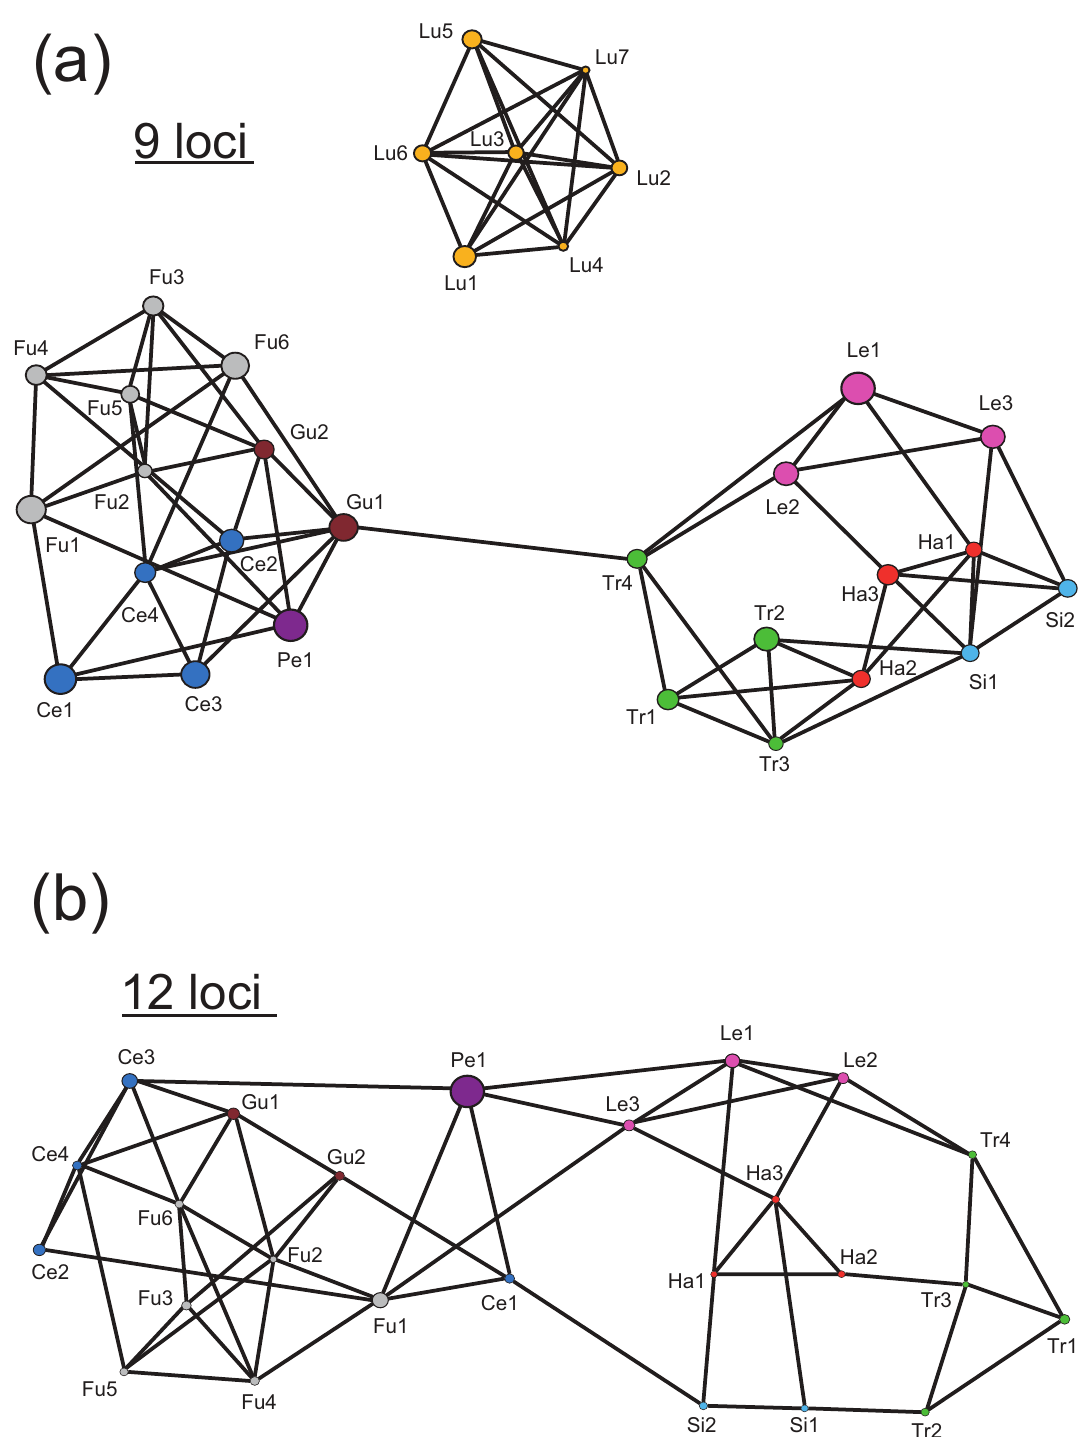
Fig 5. The results of analysesusing the POPULATION GRAPH program. (a) all populationsbasedon the nine core loci: (b) eight species (i.e. excludingdata for A . lutchuense ) based on 12 loci. Individualspecies are denotedby circles of different colors: yellow for A . lutchuense (Lu), blue for A . celsum (Ce), gray for A . fudsinoi (Fu), brown for A . gusk (Gu), dark purplefor A pellucidum (Pe), green for A . trinacriforme (Tr), red for A . hatsushimae ,magentafor A . leucosepalum , and light blue for A . simile